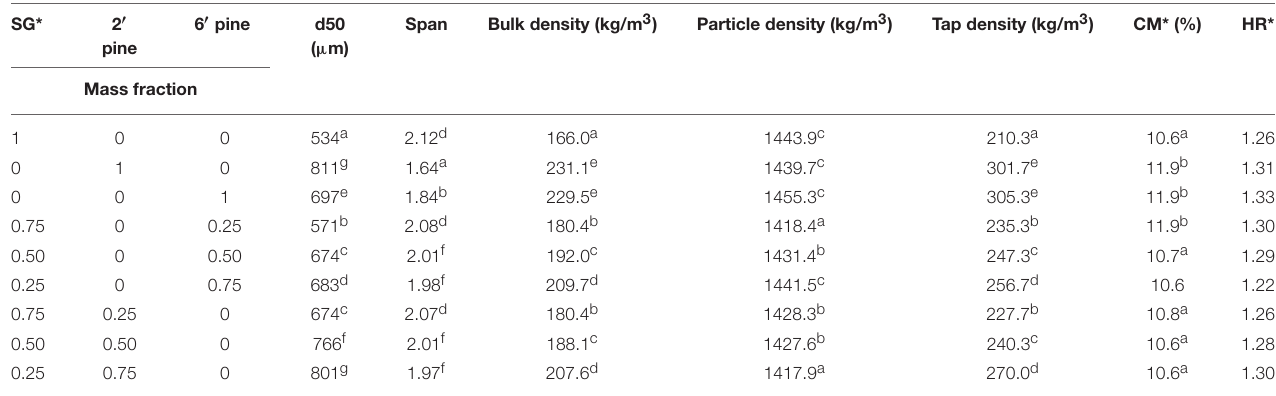
TABLE 4 | Physical characteristics of grinds from switchgrass and pine residues